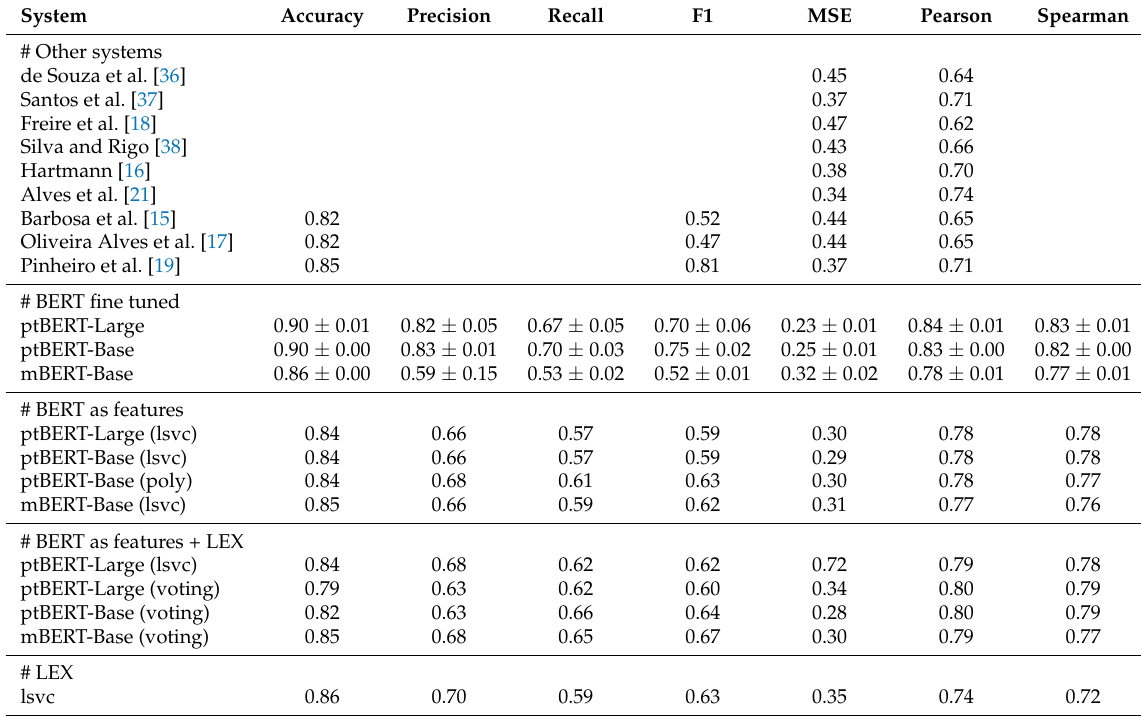
Table 3. ASSIN-PTBR NLI and STS results.